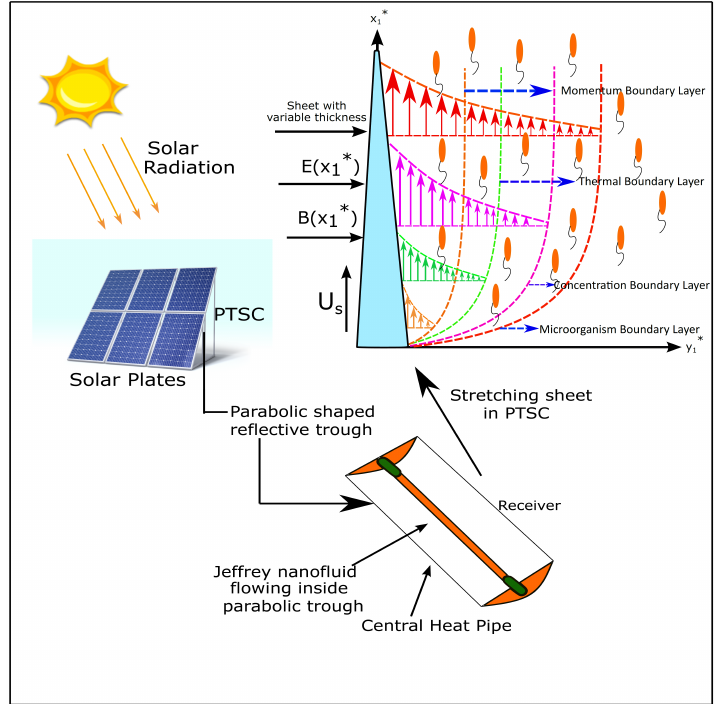
Figure 1. An illustration of the mathematical